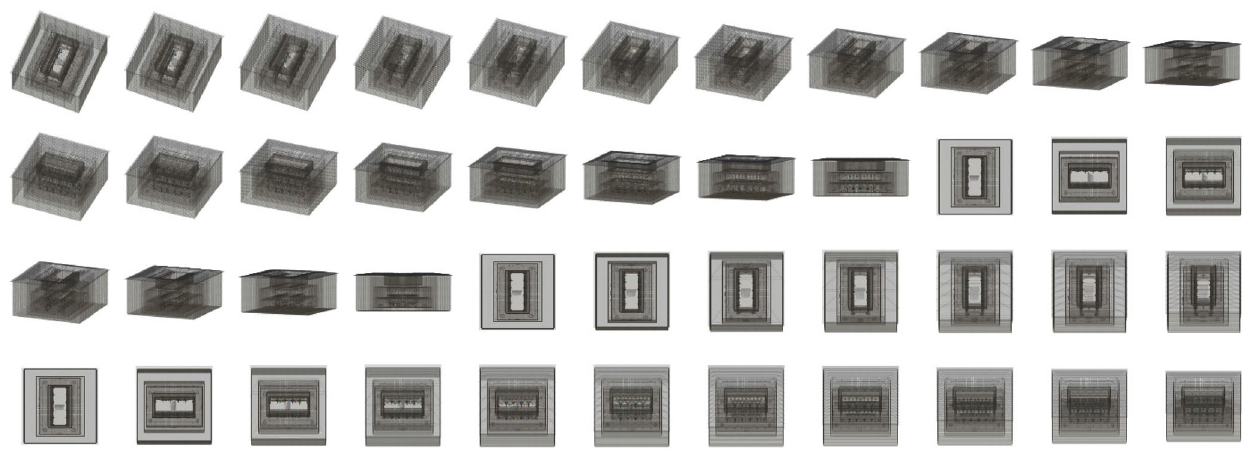
Fig. 6 Part of a CDI showing the Atrium scene as multiple deep images in different